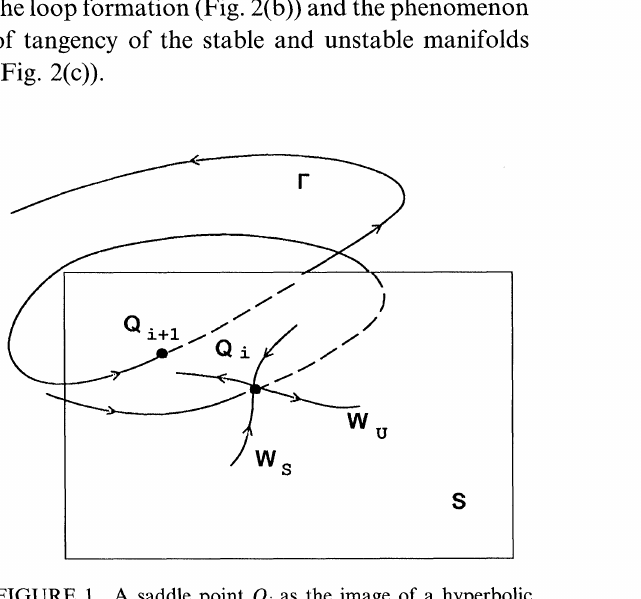
A saddle point Qi as the image of a hyperbolic trajectory in the Poincare section.